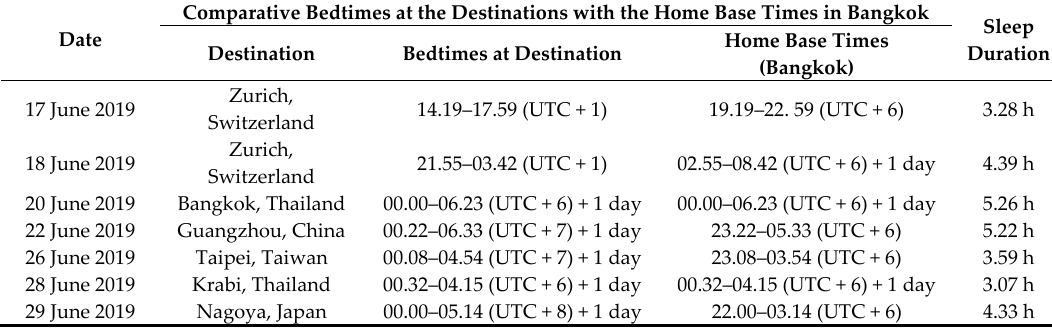
Table 9. Analyzed data from the Fitbit application of the 1st Male Flight Attendant.